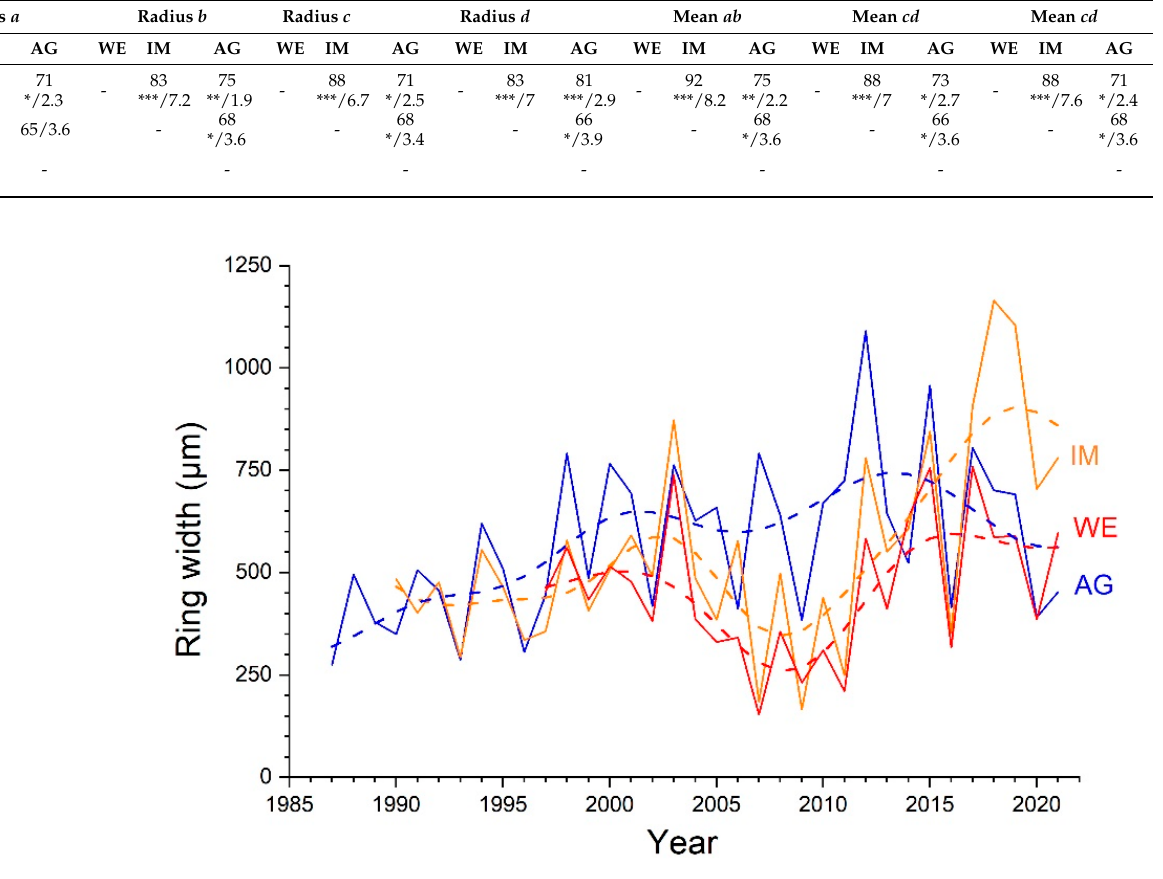
Figure 7. Long-term trend in ring-width series (mean of all radii, i.e., abcd ) of all shoots of Alnus alnobetula sampled at a wind-exposed ridge (site WE), an intermediate site (IM) and a north-facing avalanche gully (site AG). Long-term trends (dashed lines) were calculated by fast Fourier transform low-pass filter (3 yrs).